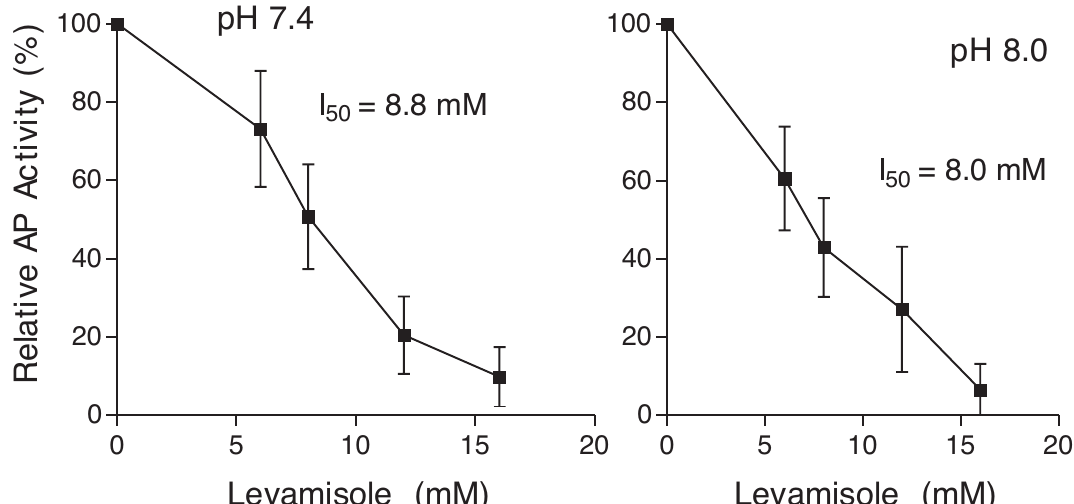
f ig . 5. – dose-dependent inhibition of aP activity by levamisole in chela muscle of C. angulatus at pH 7.4. Maximal levamisole-sensitive aP activity was taken as 100% (1955±524.1 and 1689.5±278.1 nmoles pnP x min -1 x mg prot -1 at pH 7.4 and 8.0, respectively). i 50 :